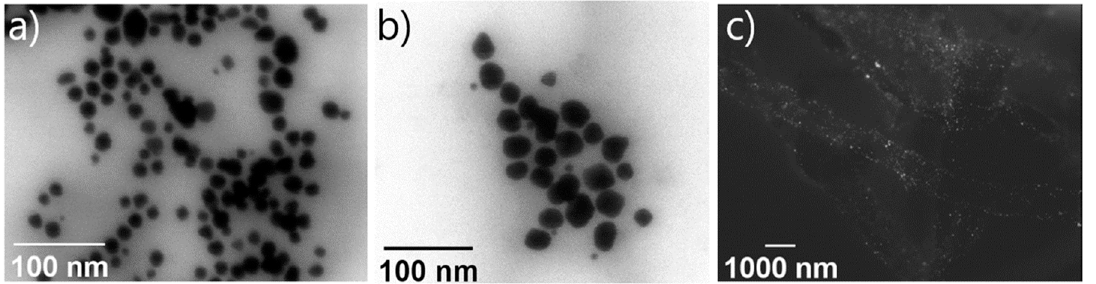
Figure 6. STEM micrographs of nanocomposites: HPAM-Au5 ( a ), HPAM-Au7 ( b ), HPAM-Au14 ( c ). HPAM-Au5 and HPAM-Au7 are composed of heterogeneous nanoparticles and large agglomerates. This is attributed to the irregular nucleation–growth zones due to the coil conformation favored by the polymers with mostly non-hydrolyzed segments.